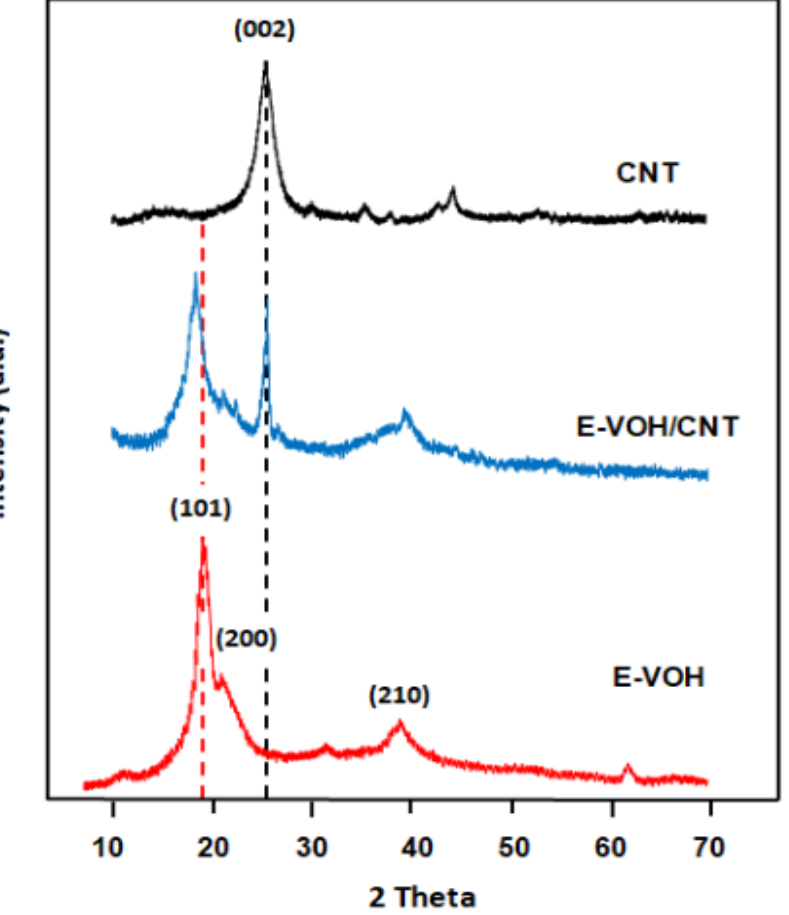
Figure 4. X-ray di ff raction (XRD) patterns of pure E-VOH, pure carbon nanotubes (CNTs), and E-VOH / CNT nanocomposite containing 1.0 wt % of Figure 4. X-ray diffraction (XRD) patterns of pure E-VOH, pure carbon nanotubes (CNTs), and E- VOH/CNT nanocomposite containing 1.0 wt % of CNTs.